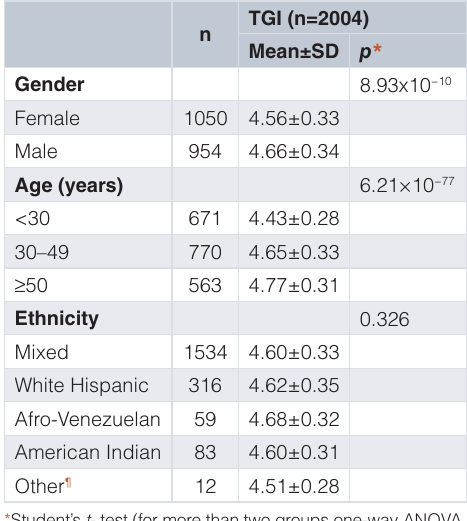
Table 3. Epidemiological behavior of the triglyceride-glucose index in the reference population according to sociodemographic variables, in Maracaibo city, Venezuela.